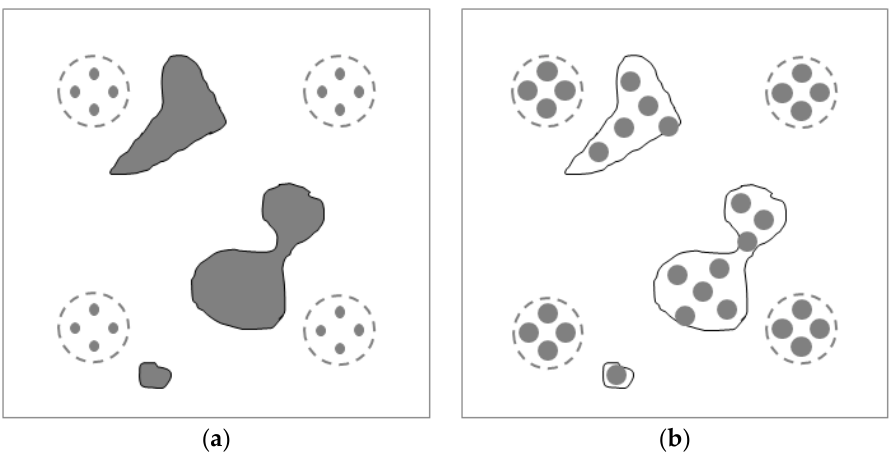
Figure 1. Schematic depiction of different regeneration sampling schemes used in this study (grey = sampling area): ( a ) 5 m 2 circular sample plots systematically distributed within overstory measurement plots in 2009 (dashed line) and 100% inventory of all seedlings and saplings in canopy gaps 2009 (black line); ( b ) 10 m 2 sample plots systematically distributed within overstory measurement plots in 2014 (dashed line) and 10 m 2 sample plots systematically distributed within canopy gaps in 2014 (black line). Table 3. Sampling method and number of regeneration plots with different sizes.